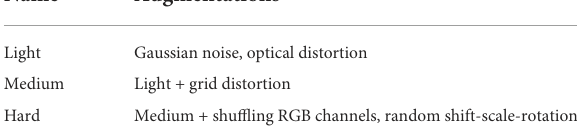
Algorithm 2. Simple2D.